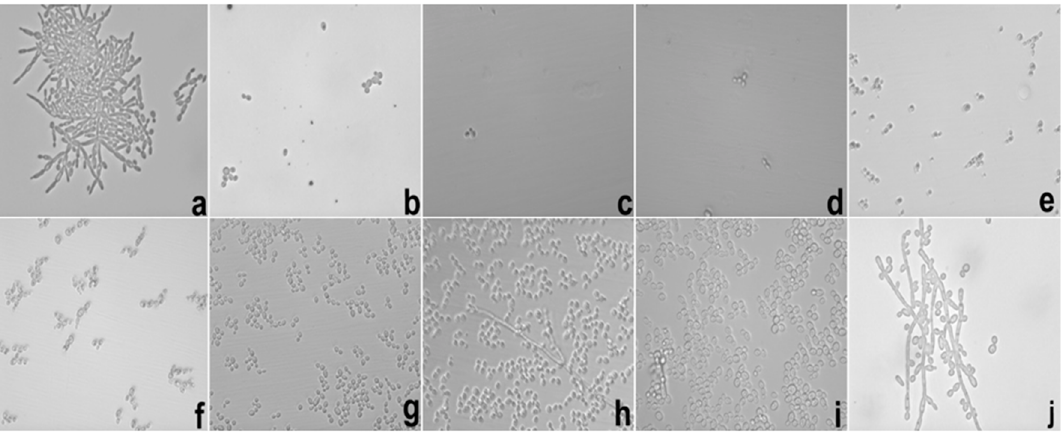
Figure 8. Photomicrography of 24 h of the hyphae inhibition test of C. albicans realized with SE. Legend: ( a ) growth control; ( b ) amphotericin B 16 μ g/mL; ( c – j ) SE from 1000 to 7.8 μ g/mL in descending order. SE = Formulation with extract.